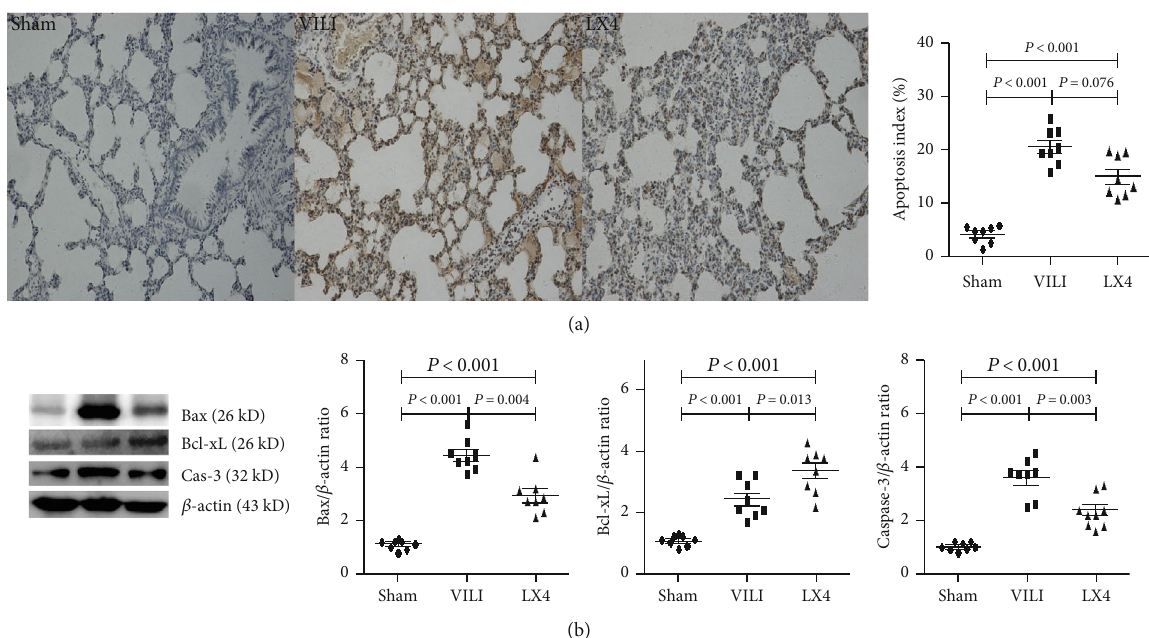
Figure 6: Lipoxin downregulated the apoptotic index in VILI. The number of apoptotic cells in lung tissue was increased in rats that received 4 hours of MV. Cellular apoptosis was signi fi cantly lower in the LX4 group than the VILI group (a). Compared to the VILI group, the LX4 group had a notably inhibited expression of Bax and caspase-3 but increased Bcl-xL expression in lung tissue (b). ∗ P < 0 : 05 , vs. the sham group; # P < 0 : 05 , vs. the VILI group. ● : sham group; ■ : VILI group; ▲ : LX4